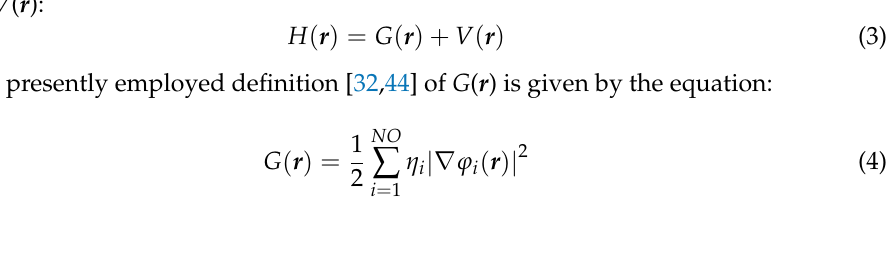
Table 2. Criteria to assign the Ng-X bonds in terms of covalency. ρ s (ave) a H ( Ω s ) Notation Cov ≥ 0.08 invariably negative H − <0.08 invariably negative H − pCov any value from negative to positive nCov any value invariably positive H + − 3 a ea 0